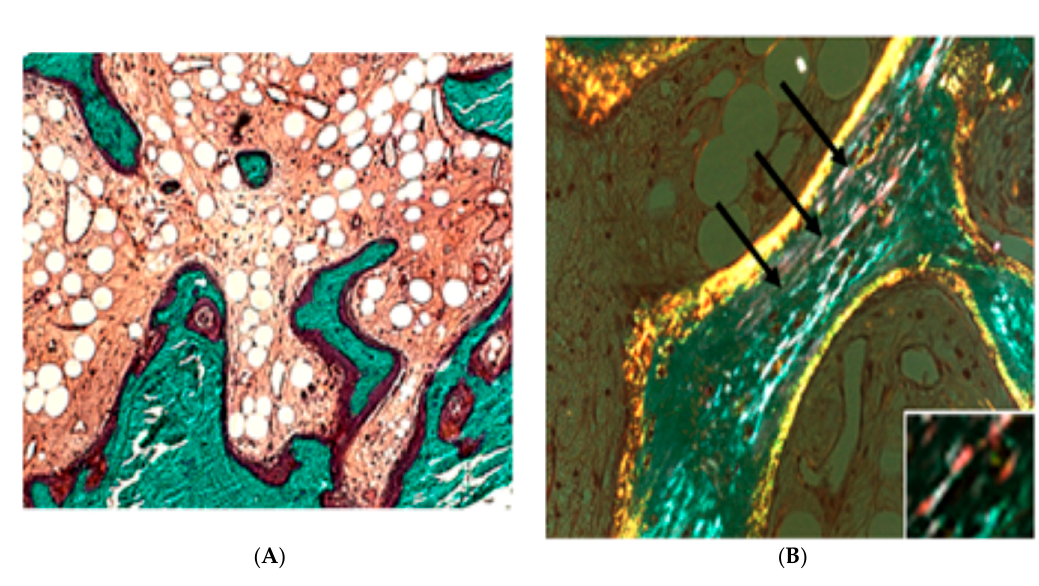
Figure 2. Defects in bone mineralization due to the lack of PEDF. ( A ) Iliac bone section of a patient affected by OI type VI. A large amount of unmineralized osteoid (in red) and resorption lacunae are visible. ( B ) Bone section under polarized light. Black arrows point to the so called “fish-scale” pattern (magnification 200×) (Reproduced from J. Bone Miner. Res. 2012, 50 , 343–349, with permission of the American Society for Bone and Mineral Research). The insert in ( B ) shows an enlargement of fish scale (2000×).